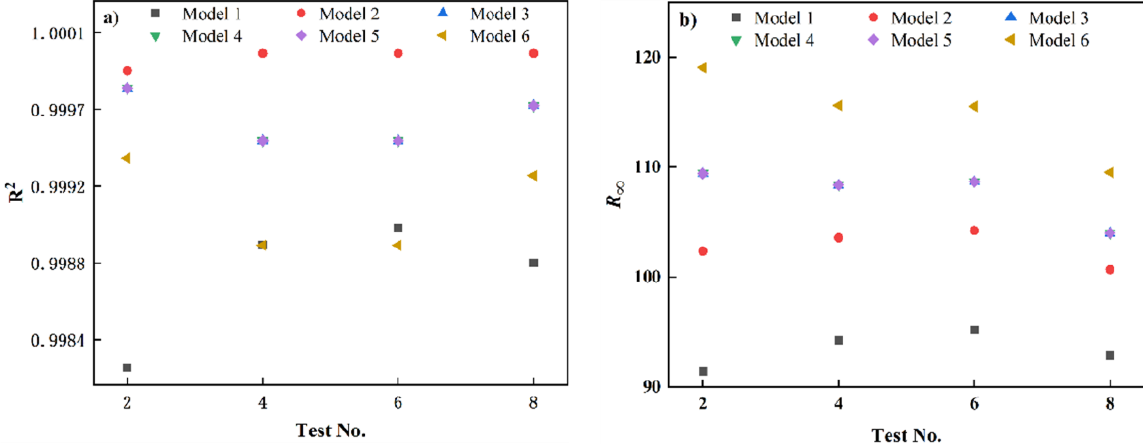
Figure 3. ( a ) R 2 values and ( b ) maximum recoveries ( R ∞ ) of six flotation kinetic models obtained from experiments in different groups (Test 2: 2700 g/t collector, 5000 g/t frother; Test 4: 3700 g/t collector, 5000 g/t frother; Test 6: 5000 g/t collector, 5000 g/t frother; Test 8: 5000 g/t collector, 1800 g/t